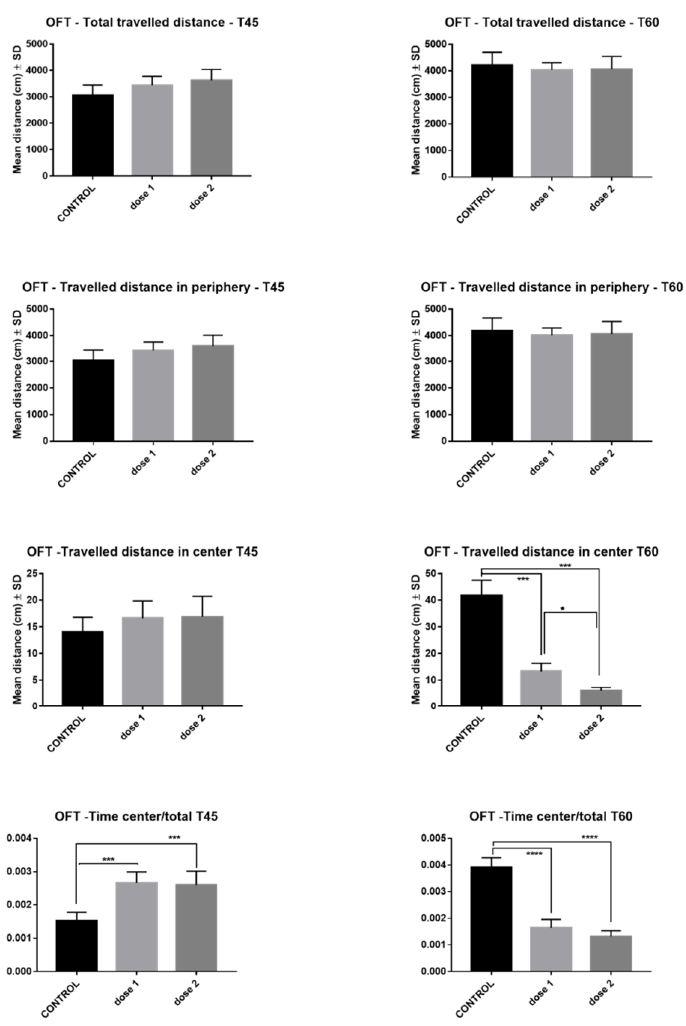
Figure 4. Open field test results–comparison between control, low-dose (D1), and high-dose (D2) groups in rats sacrificed immediately after end of treatment (T45) and those sacrificed 15 days post-treatment (T60). * p < 0.05; *** p < 0.001; **** p < 0.0001.